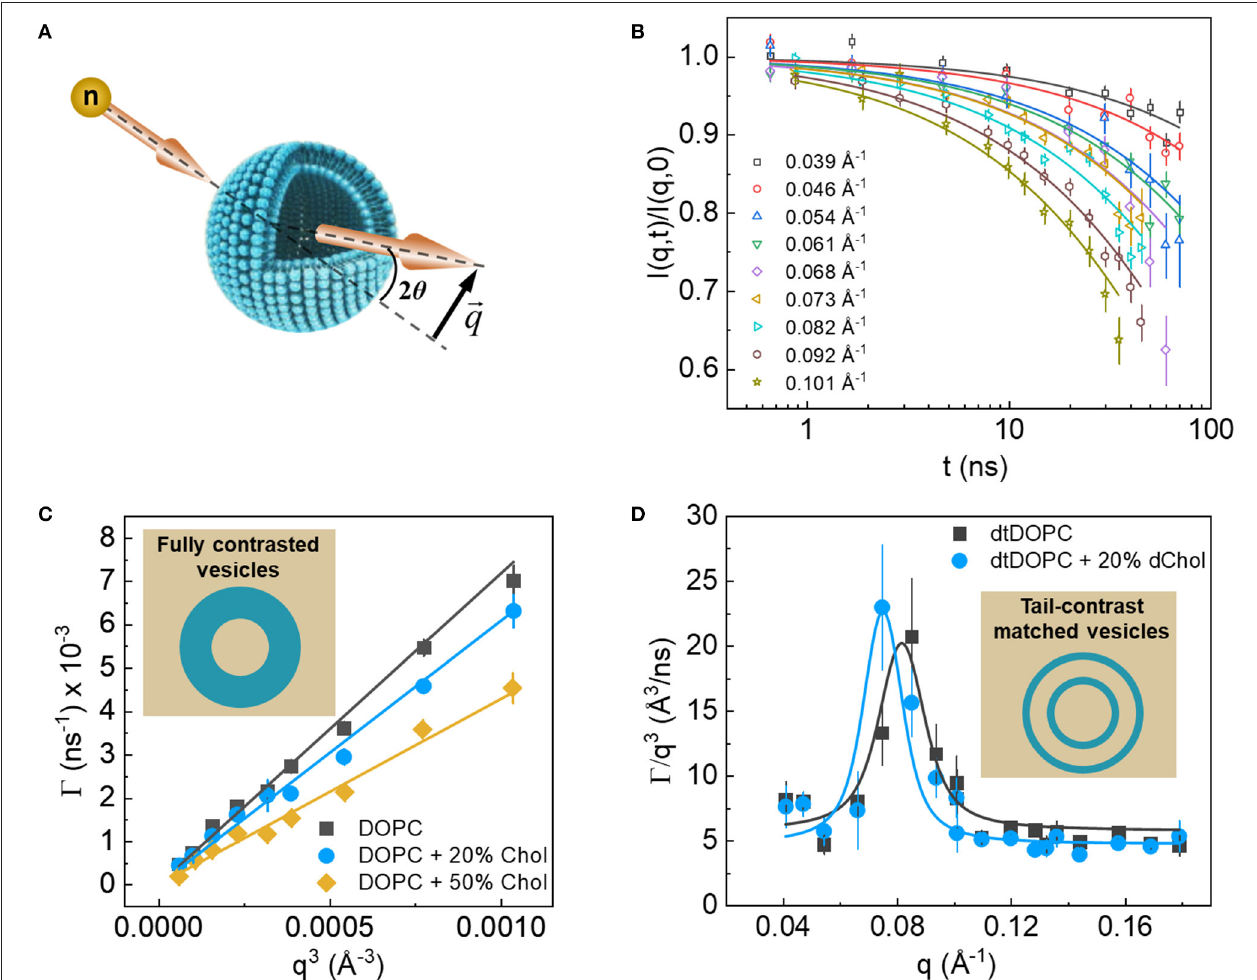
FIGURE 8 | (A) Schematic of the scattering geometry used in NSE experiments. (B) Example of the NSE intermediate dynamic structure factors resulting from ULVs. (C) Plot of the q 3 dependence of fluctuation decay rates of protiated membranes in D 2 O (inset), where shallower slopes indicate stiffer membranes according to the Zilman-Granek theory. (D) Excess dynamics, typical of thickness fluctuation signals from tail contrast matched membranes (inset). Data are adapted from Chakraborty et al. (Figures 2,